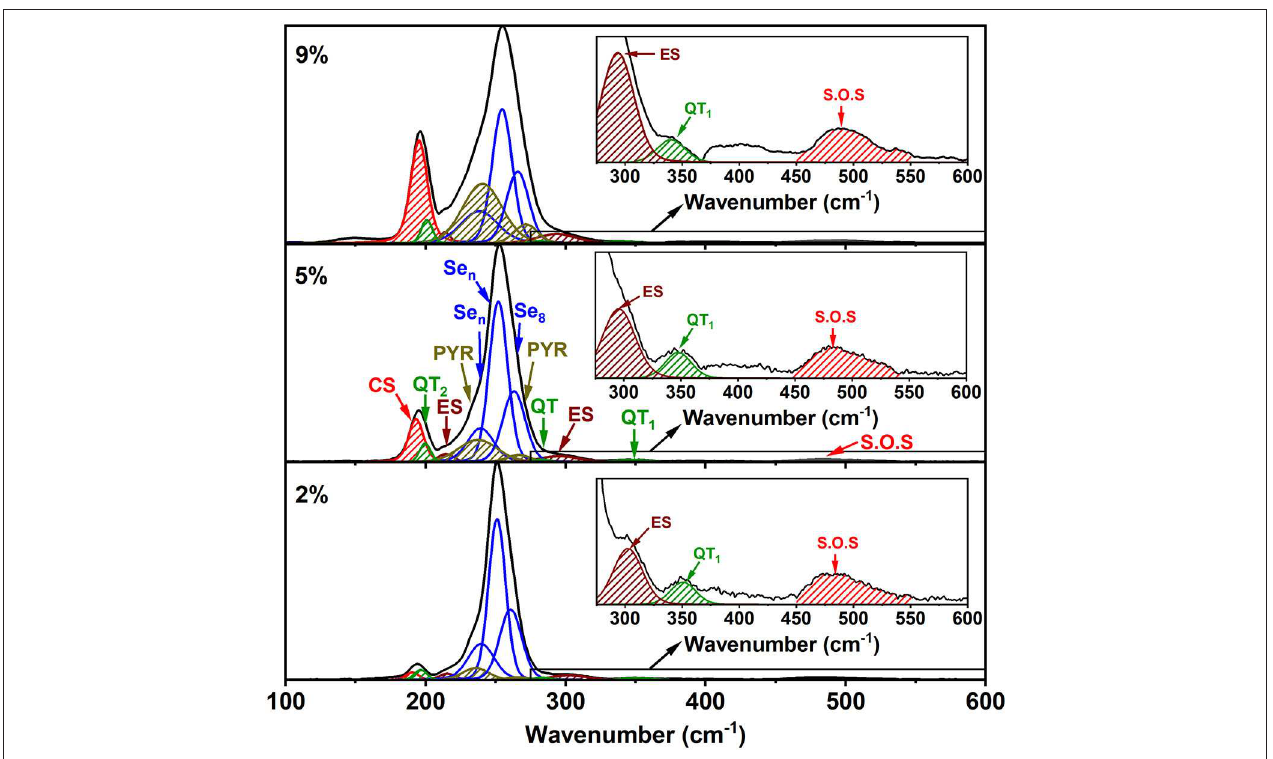
FIGURE 8 | Raman line shape deconvolution at several glass compositions in the low x regime of the present ternary. These modes are in harmony with the expected vibrational modes of the characteristic local structures as shown in Table 1 . In the high frequency range spanning 300–600 cm − 1 , we illustrate in the inset evidence of the 350 cm − 1 mode coming from the As-centered QT units. The red hash-marked mode represents second order scattering from the Se n chain mode near 250 cm − 1 . See